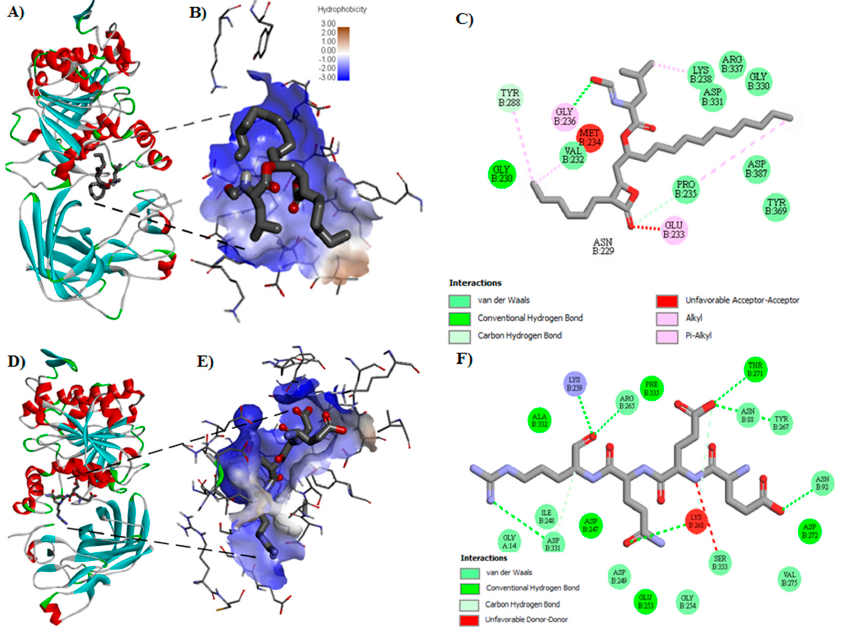
Figure 1. Molecular docking diagrams exemplifying interactions between pancreatic lipase (PL) enzyme (PDB: 1LPB) and inhibitors. ( A ) Example of the pose of orlistat with the enzyme PL. ( B ) The identified pocket of PL interact with orlistat determined by molecular docking. ( C ) Potential interactions with the amino acid residues from the PL catalytic site in two dimensional (2D) with orlistat. ( D ) The best pose of peptide EEQR with the enzyme PL. ( E ) The identified pocket of PL interact with peptide EEQR determined by molecular docking. ( F ) Potential interactions with the amino acid residues from the PL catalytic site in 2D with peptide EEQR.